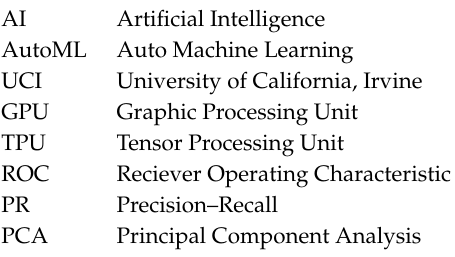
Table S1: Validation performances of different algorithms on Heart UCI dataset over days, Table S2: Validation performances of different algorithms on Cardiovascular disease dataset over days, Table S3: Descriptions and parameter settings of algorithms used by the graduate student on the